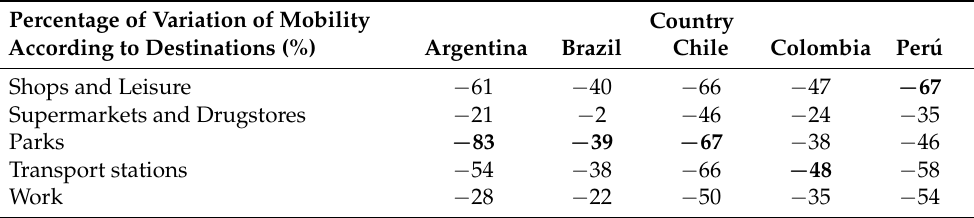
Table 4. Percentage of variation (increase +, and reduction − ) of mobility, according to destinations, during the COVID-19 pandemic in Argentina, Brazil, Chile, Colombia and Per ú . Percentage of Variation of Mobility According to Destinations